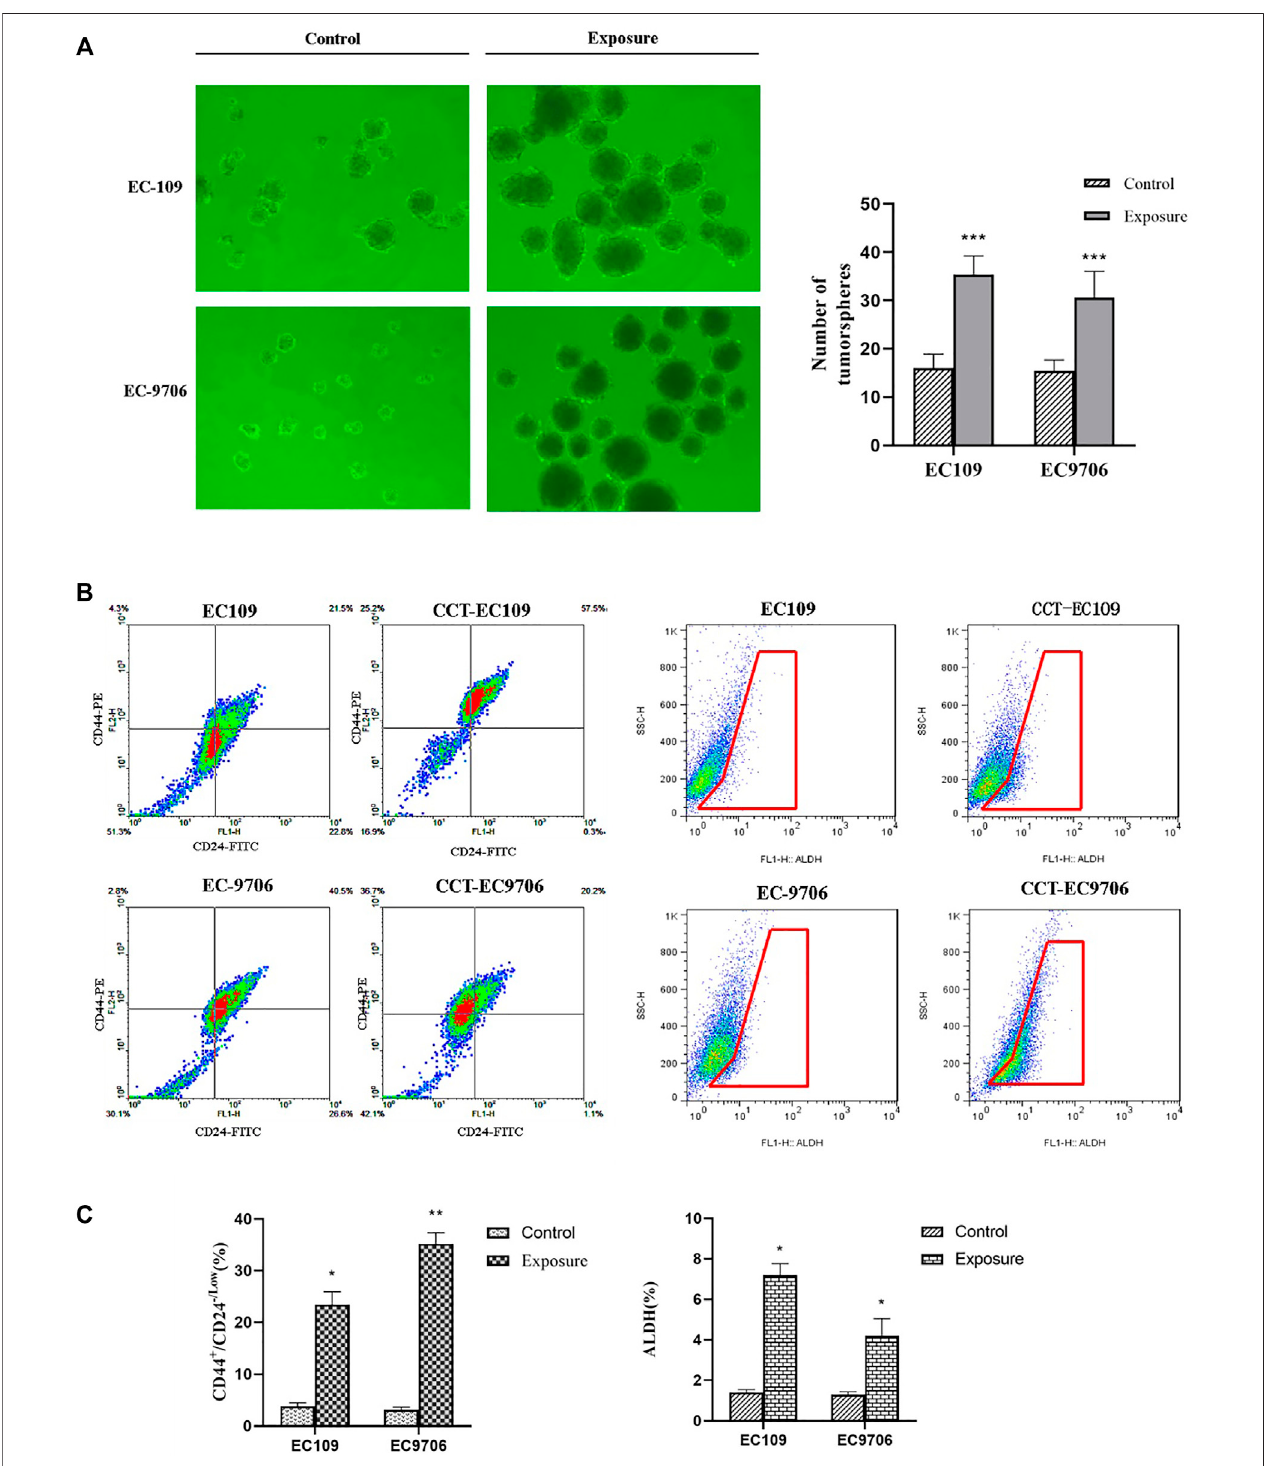
FIGURE 5| Number of tumor spheres over 50 cells was counted in the Cd exposed and control groups (A) and fl ow cytometric analysis for CD44 + /CD24 -/Low (left panel of (B,C) and ALDH (right panel of B&C) expression in CCT-ESCC cells and controls. Data present Mean ± SD from 3 independent experiments. * p < 0.05, ** p < 0.01, *** p < 0.001.